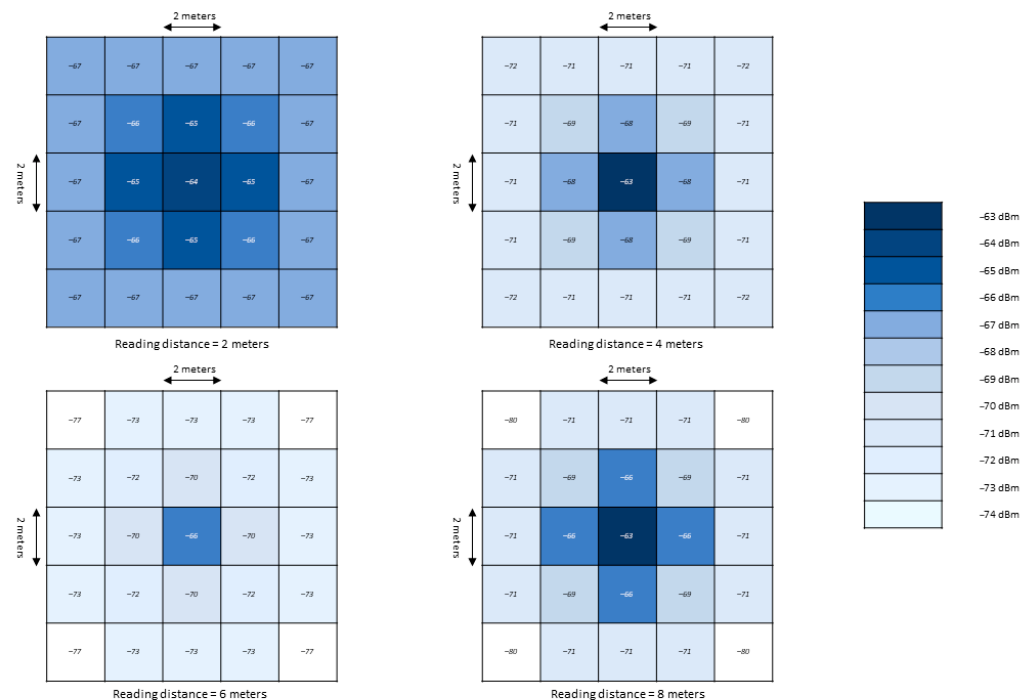
Figure 3. Averaged measured RSSI for individual RFID tags located in the matrix.